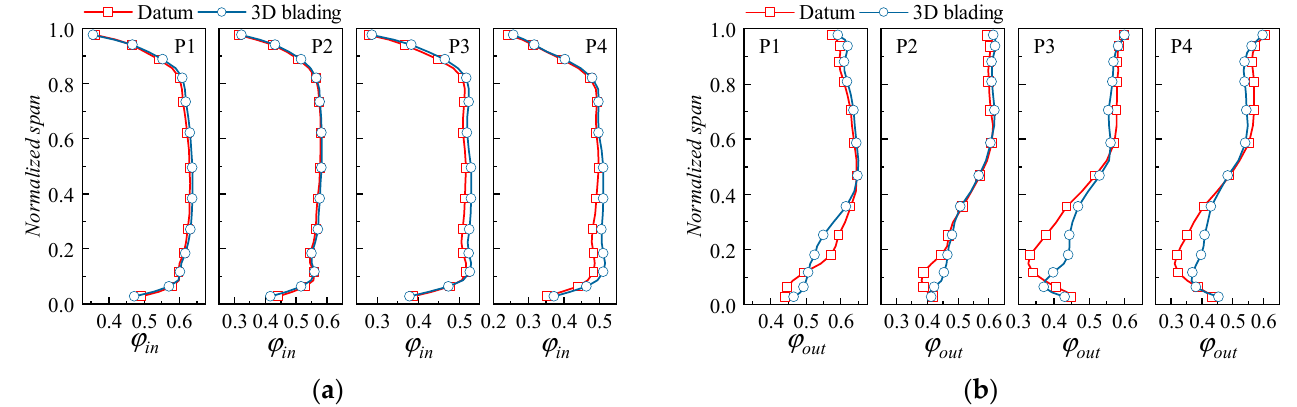
Figure 33. The radial distribution of mass flow coefficients under different operating coefficients: ( a ) inlet mass flow coefficient; ( b ) outlet mass flow coefficient.